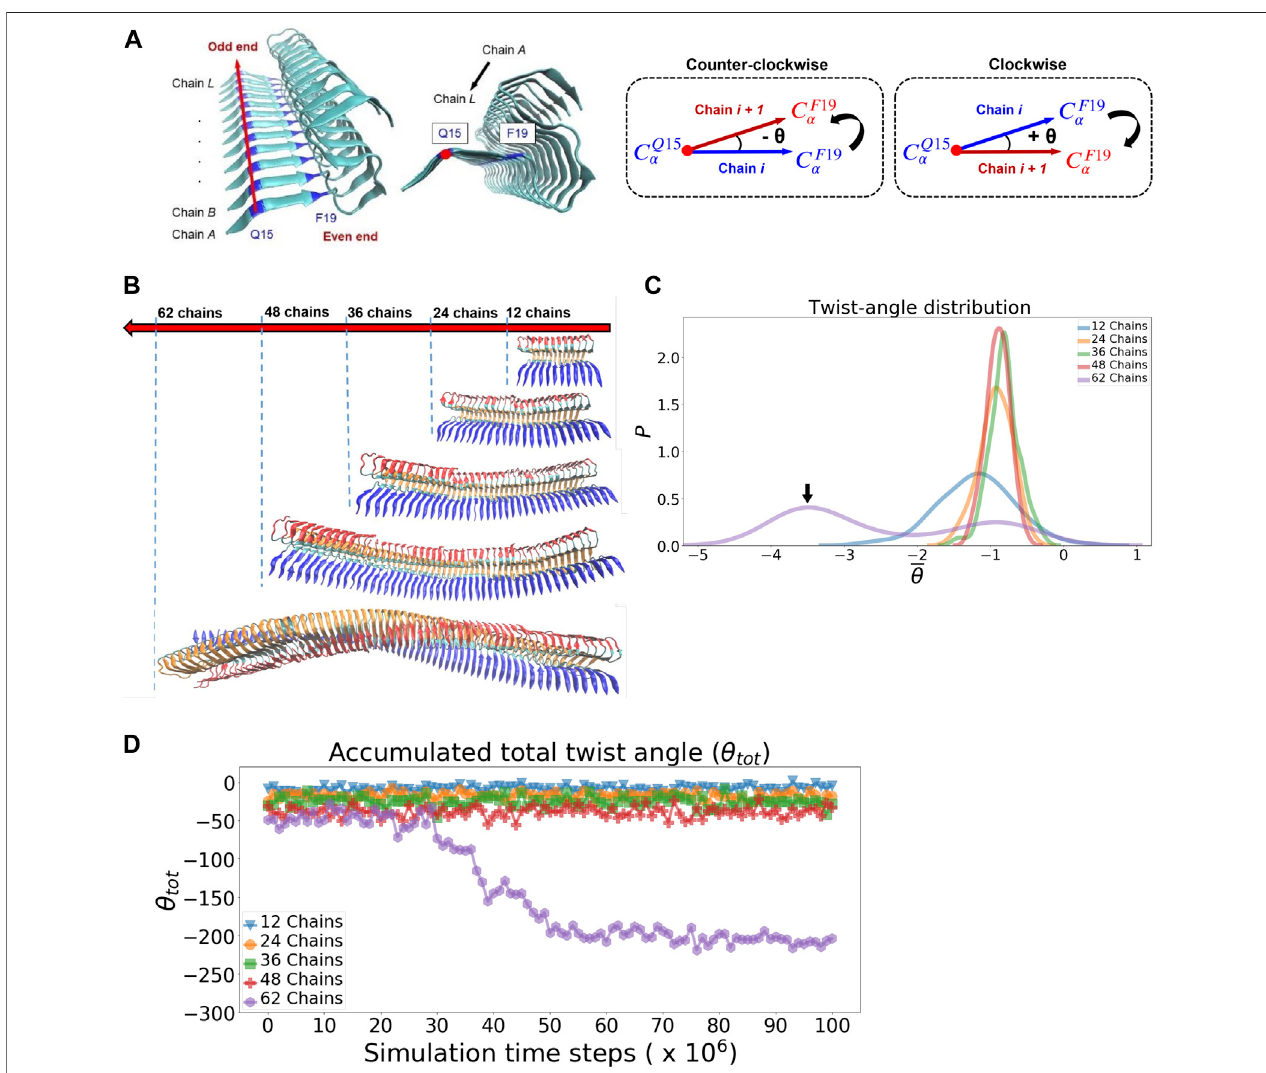
FIGURE6| Fibrillartwisting ofproto fi lamentsofdifferentsizesisanalyzed andcompared. (A) Thede fi nitionofthe fi brillartwistangle θ isshown. (B) Representative fi brillarstructuresofdifferentsizesaredisplayed(fromtop,12,24,36,48,and62chains). (C) Distributionoftheaveragedtwistangleperchain( θ ̄ )fortheproto fi lamentsof differentsizes.Theblackarrowindicatesthesecondpeakofthe62-chainproto fi lament,whichrepresentsthetwistingstructureofthe62-chainproto fi lamentseenin (B) . (D) Accumulated total twist angle( θ tot ) for proto fi lamentsof different sizes. For each of the fi lament species, the twist angle of each chain is added up to yield a fi nal totaltwistangle.Notethattheinitialstructure oftheproto fi lamentmodelistakenfromthelastframeofapre-equilibrationsimulation (see SupplementaryFigureS10 in the Supporting Information for details).